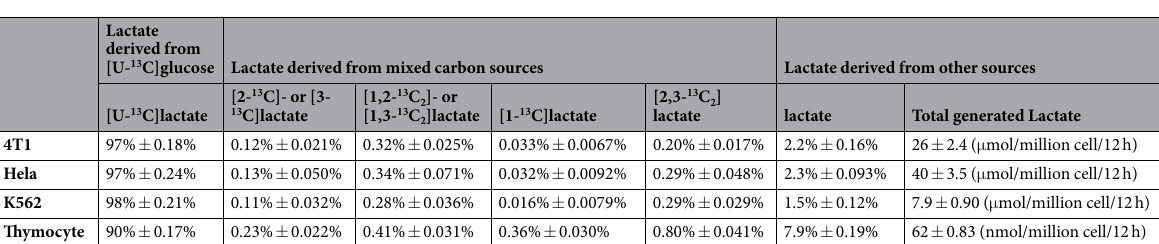
2. Glucose metabolism through pentose phosphate pathway then back to glycolysis would generated 3 major species (Fig. 3), lactate ( m / z 89 > 43), [1,3- 13 C 2 ]lactate ( m / z 91 > 44), and [3- 13 C]lactate ( m / z 90 > 44), the ratio of ([1,3- 13 C 2 ]lactate + [3- 13 C]lactate)/lactate should be 2/3 (Fig. 3). Thus, glucose entering into pentose phosphate pathway then back to glycolysis would also generate a fraction of lactate ( m / z 89 > 43). 3. According to Table 1, the other sources generated about 2% of lactate ( m / z 89 > 43). Thus, the percentage of lactate from glycolysis, pentose phosphate pathway, and other sources were about 90%, 6.6%, and 2.2%, respectively (the down part of Table 2), accounting for about 99% of total lactate. Using Hela and K562, we obtained nearly identical results (Table 2). For thymocytes, the percentage of lactate from glycolysis, pentose phosphate pathway, and other sources were about 85%, 6.0%, and 7.9%, respectively, accounting for about 99% of total lactate (Table 2). Then we used [3- 13 C]glucose to trace lactate generation from glycolysis and pentose phosphate pathway by 4T1 cells and calculated the percentage of lactate (Table 3). The calculation is similar as described above. In theory (Fig. 4), glycolysis would generate 2 species, [1- 13 C]lactate ( m / z 90 > 44) derived from glucose carbons 1, 2, 3, and, lactate ( m / z 89 > 43) derived from glucose carbons 4, 5, 6; glucose metabolism through pentose phosphate